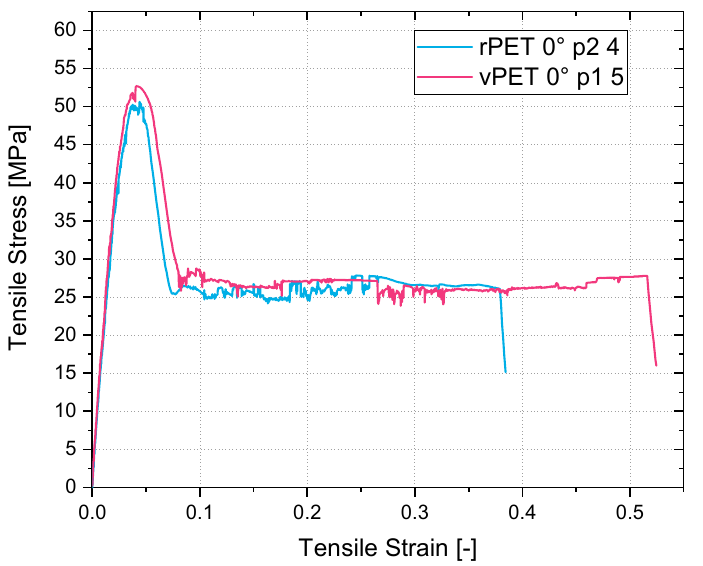
Figure 16. Stress–strain diagram for samples with a ductile fracture at 0° bead orientation.